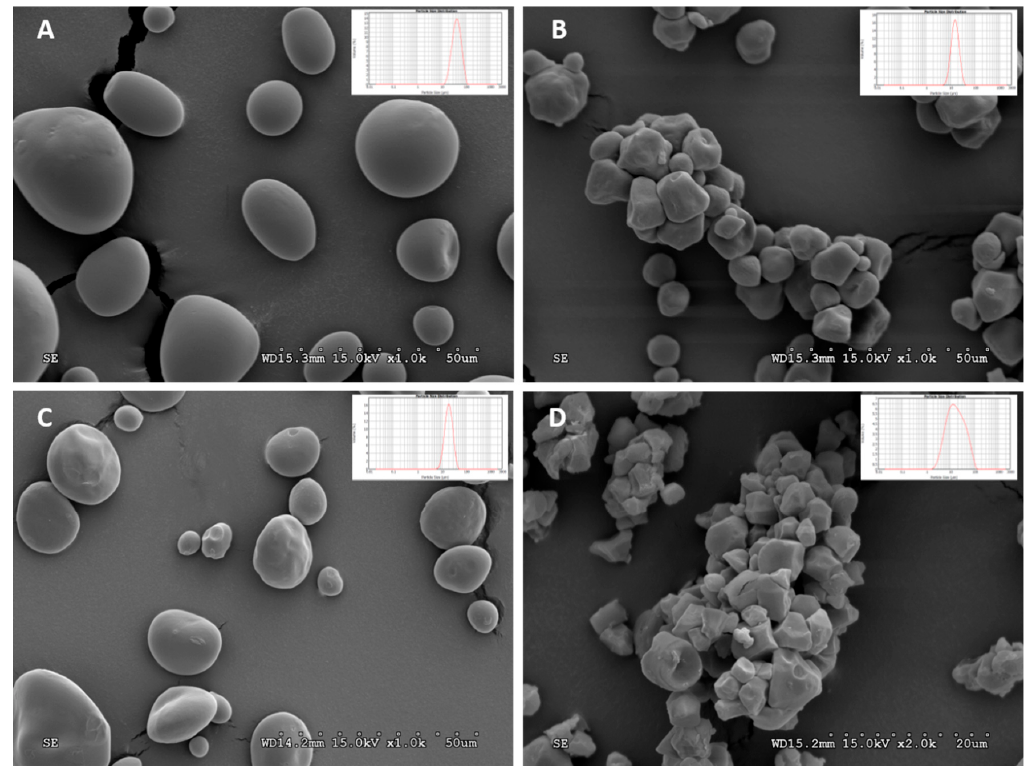
Figure 1. SEM micrographs of ( A ) potato starch (1000×), ( B ) corn starch (1000×), ( C ) wheat starch (500×), and ( D ) rice starch (2000×). Different magnifications were used for a clearer observation of the granules. The particle size distribution profiles, as measured by laser diffraction, are given for each starch.